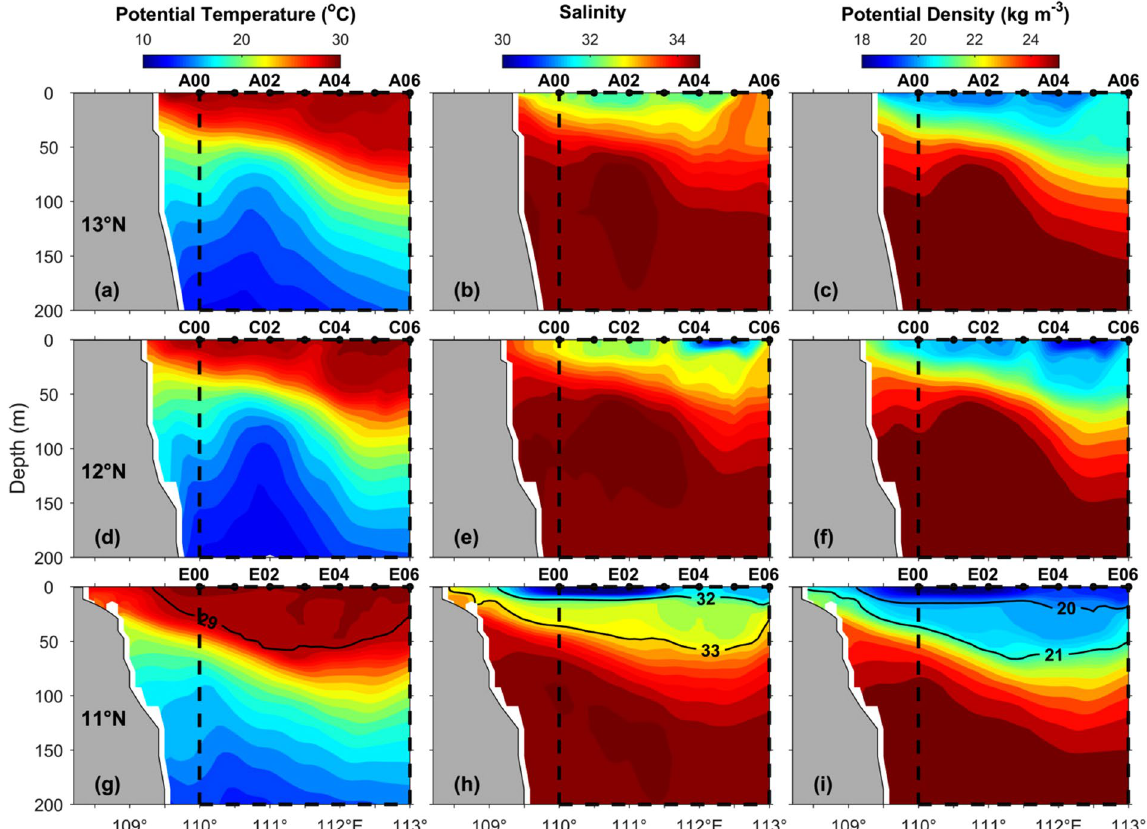
Figure 4. Sectional distributions of thermohaline properties based on CMEMS reanalysis. Similar format as Fig. 2 except that the observations are only confined to the east of 110°E as bounded by the dash box in each panel of this figure. The figure is generated using Matlab R2011a